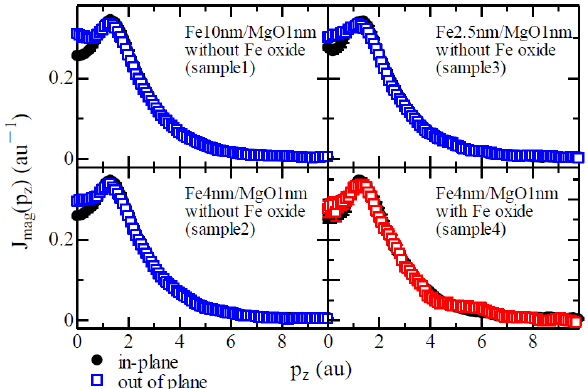
Figure 4. Magnetic Compton profiles (MCPs) for Fe/MgO multilayered films. Open squares and closed circles denote the MCPs in the applied magnetic field perpendicular (out of plane) and parallel (in-plane) to the film plane, respectively.